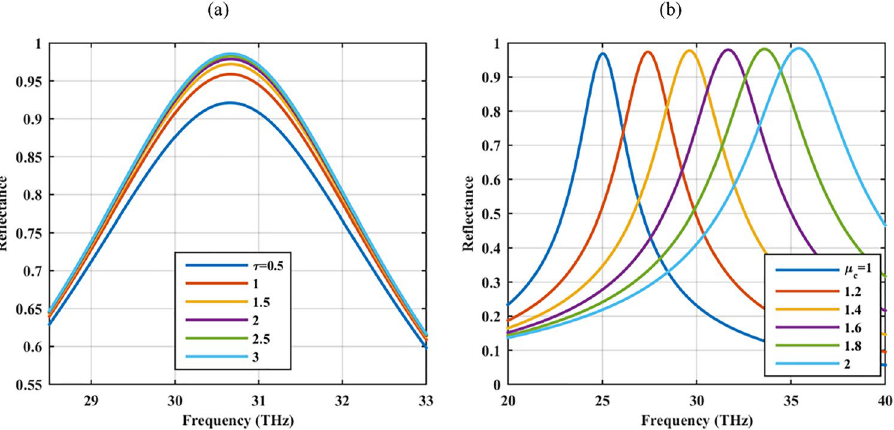
Figure 4. Reflectance of the graphene-coated hole array for different graphene optical parameters ( a ) relaxation time τ (ps) and ( b ) chemical potential µ c